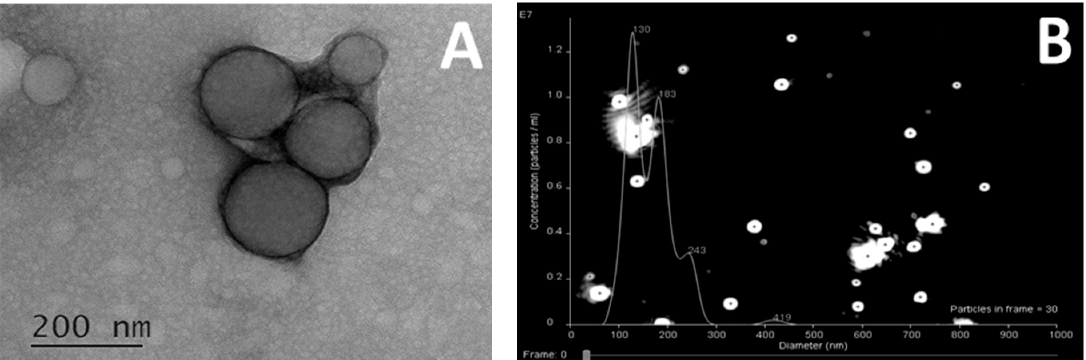
Figure 1. Size and structure of polypeptide nanoparticles (sample KEI2), investigated by TEM ( A ) and NTA ( B ).